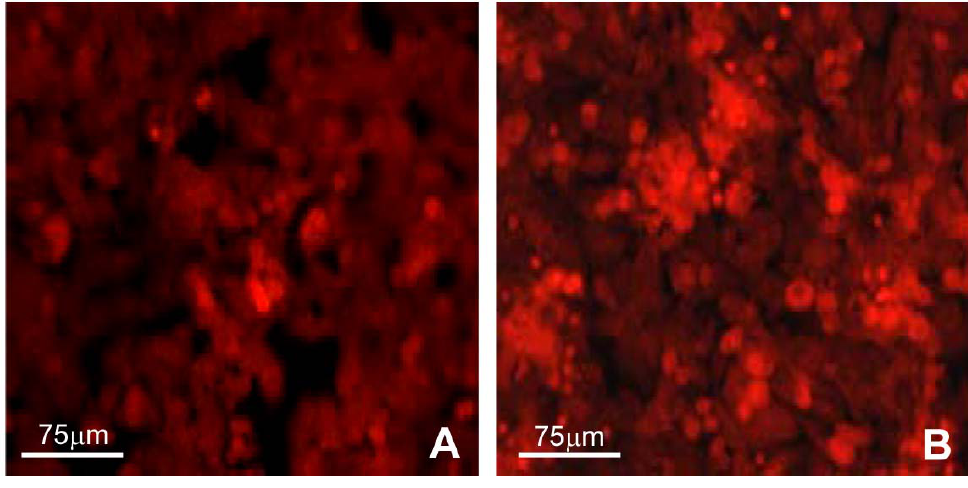
Figure 1. Confocal microscopy of J111 cells grown on a plastic surface for 3 (A) and 5 (B) days. Cells were labeled with propidium iodide prior to microscopy